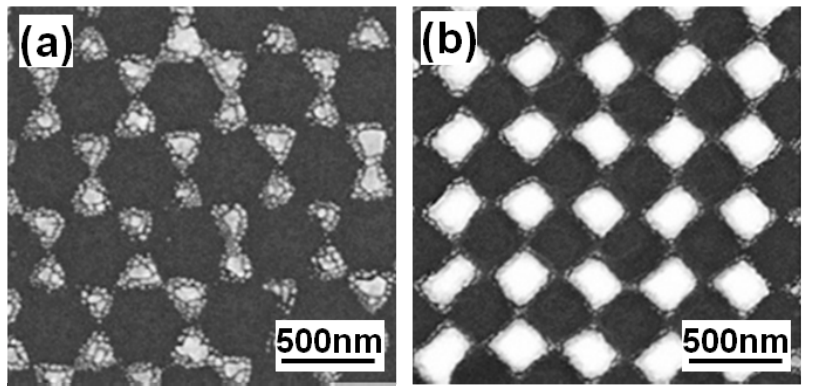
Figure 8. Surface morphologies of the fabricated hybrid Au–Ag: ( a ) hexagonal lattice of triangular; and ( b ) square lattice of quadrate periodic nanoparticle arrays.